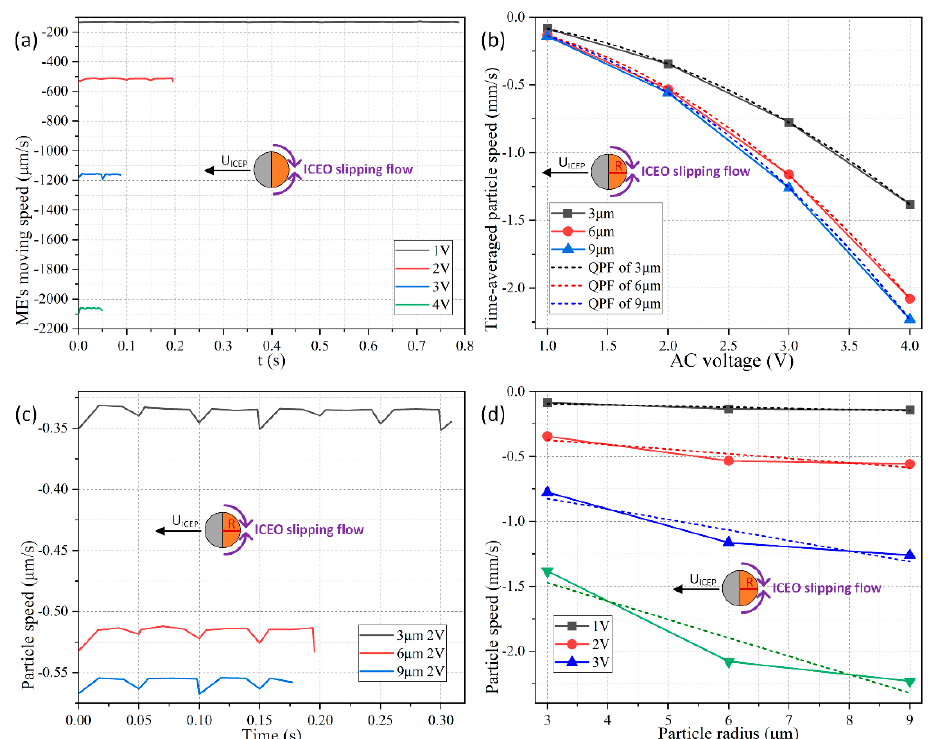
Figure 4. Parameter-dependence study of the low-frequency ICEP translation of the Janus ME in the direction of the insulating end at 100 Hz. ( a ) Moving speed of the Janus colloid as time elapses under different AC voltages at a given particle radius of 6 μ m. ( b ) Voltage-dependence of the time-averaged particle’s translating speed for different colloid radius as well as their quadratic polynomial fitting (QPF) curves. ( c ) Moving speed of the Janus colloid as time elapses for different particle radius at a given voltage of 2 V. ( d ) Diameter-dependence of the time-averaged particle’s translating speed for different voltage amplitude as well as their linear polynomial fitting (LPF) curves.